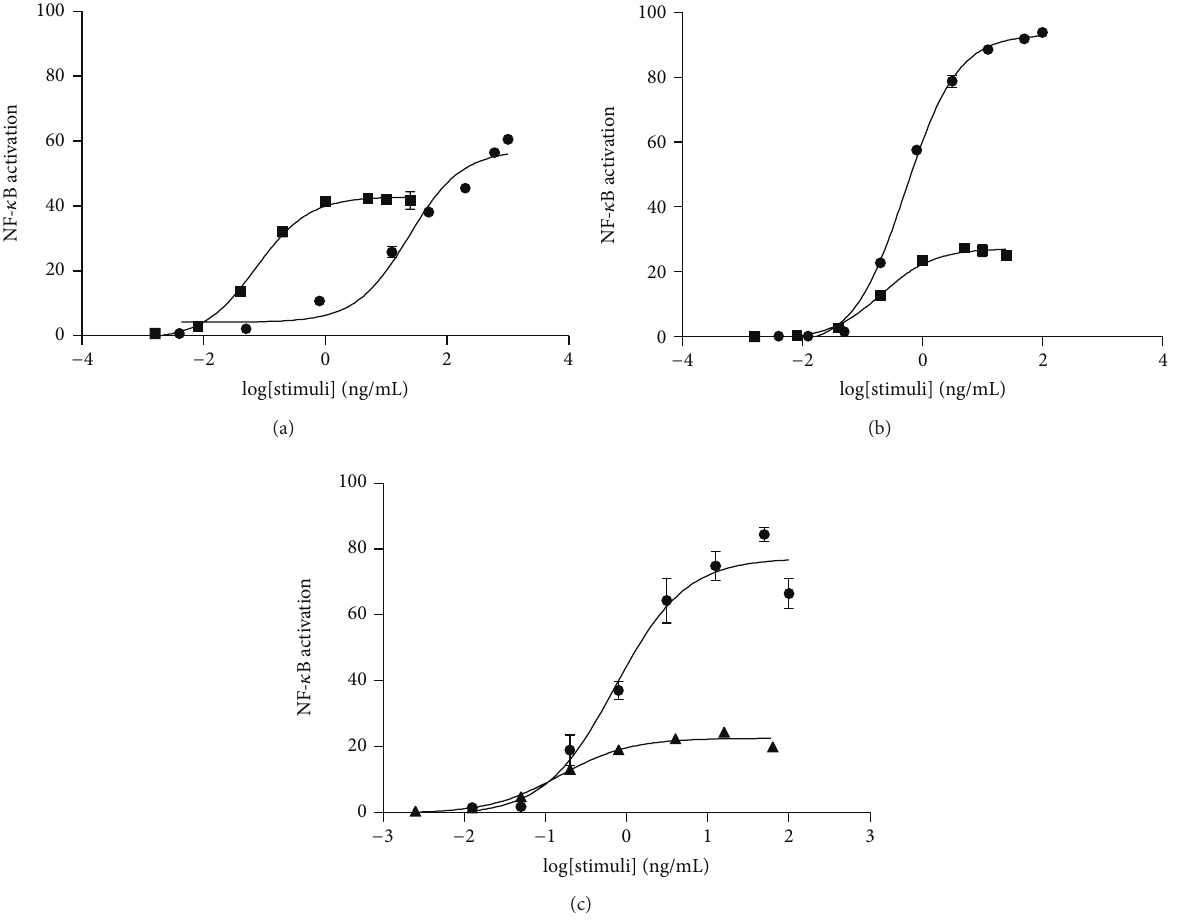
Figure 3: Activation of NF- 𝜅 B with different stimuli. Caco-2-NF- 𝜅 B-hrGFP C3 clone (a) was seeded at 1 × 10 5 cell/well and 24 h later stimulated during 48h with TNF- 𝛼 (circle) or IL-1 𝛽 (square). HT-29-NF- 𝜅 B-hrGFP E5 (b) or F6 clones (c) were seeded at 5 × 10 4 cell/well and 24 h later were treated during 18–24 h with LPS (triangle), TNF- 𝛼 (circle), or IL-1 𝛽 (square). Cells were trypsinized and GFP expression was analyzed by flow cytometry. Data was expressed as mean of triplicates with SD error bars. Data was fitted using nonlinear regression 3-parameter fit using GraphPad Prism. NF- 𝜅 B activation was determined as previously